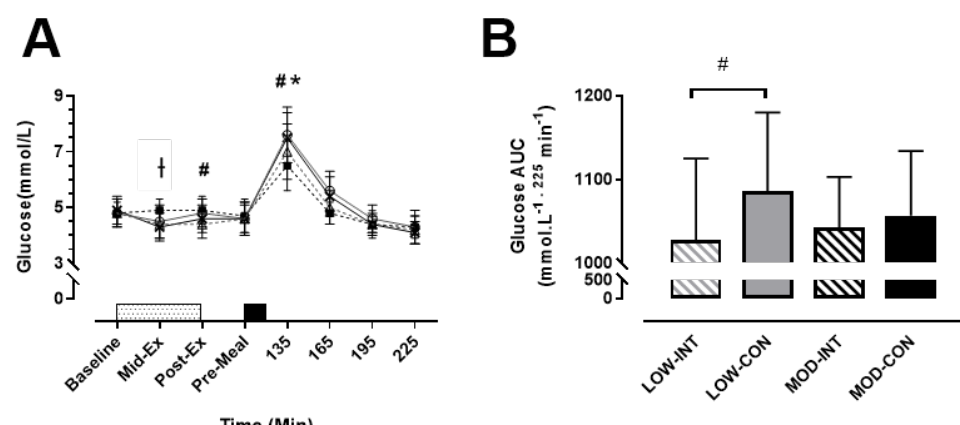
Figure 3. ( A ) Blood glucose, during the LOW-INT ( ▲ ) , LOW-CON ( ○ ), MOD-INT ( ■ ) and MOD-CON (x). Solid lines represent continuous trials and hashed lines represent intermittent trials. Data points are means with vertical error bars representing SDs ( n = 12). Unfilled rectangle with black spots indicates 60-min exercise period; filled rectangle indicates a semi-solid meal. ( B ) Bar charts represent mean blood glucose AUC response (0–225 min) to a standardised meal after exercise, with vertical error bars representing SDs. † Indicates MOD-INT trial significantly higher than all other trials. # Indicates LOW-INT are significantly different than LOW-CON. * Indicates MOD-INT are significantly different than MOD-CON, determined by Bonferroni adjusted paired t -test ( p < 0.05).